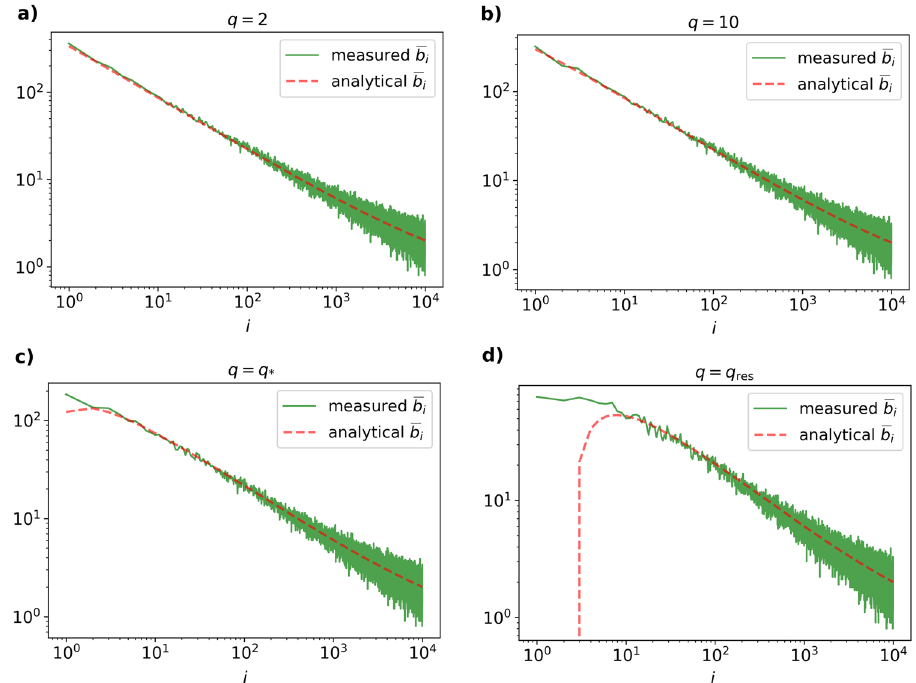
-- b i for different values of the number of Fig. 5 The expected number of intra-community links i in PSO networks as a function of the node index communities q . In all the panels a – d , the solid green curves correspond to the number of intra-community links obtained by averaging over 10 PSO networks generated independently with parameters ζ = 1, N = 10000, m = 2, β = 0.6 and T = 0.1, while the red dashed lines show the analytic prediction for the same model parameters. The number of communities used for creating panel c and panel d at this parameter setting were q * = 48 and q res ¼ 133,